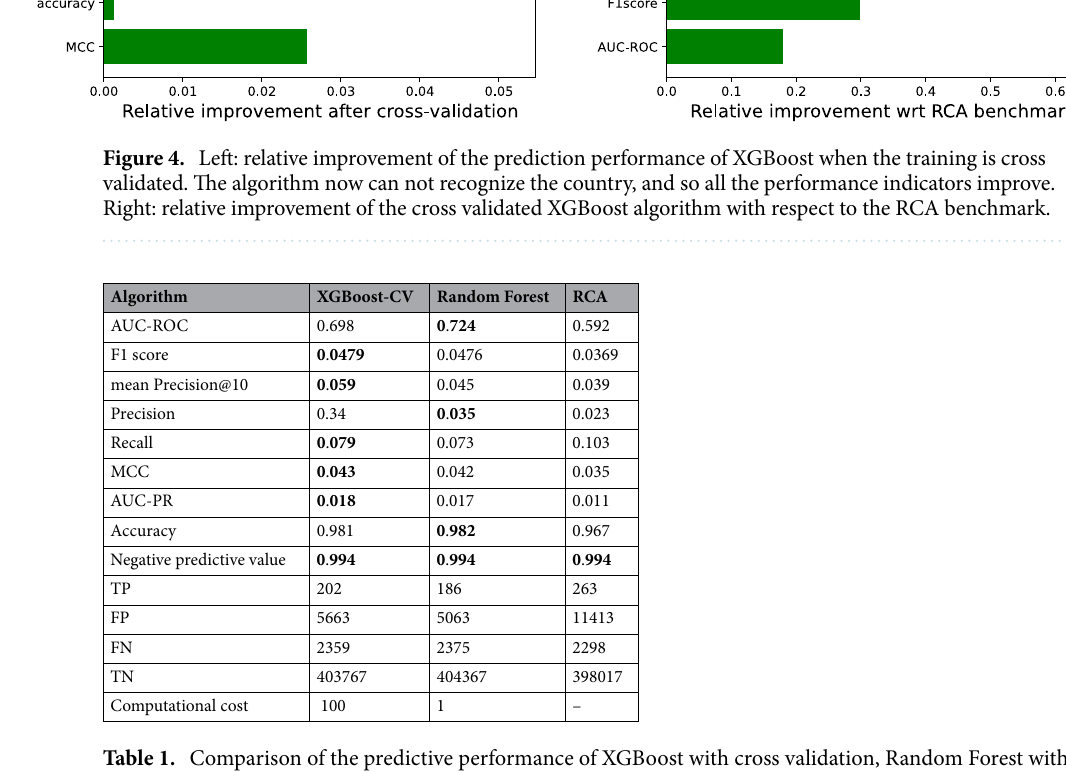
Table 1. Comparison of the predictive performance of XGBoost with cross validation, Random Forest without cross validation and the RCA benchmark for the activations using different indicators. The last row indicates the computational cost with respect to the non cross validated Random Forest; XGBoost is about 100 times slower. The highest values of each indicator are in